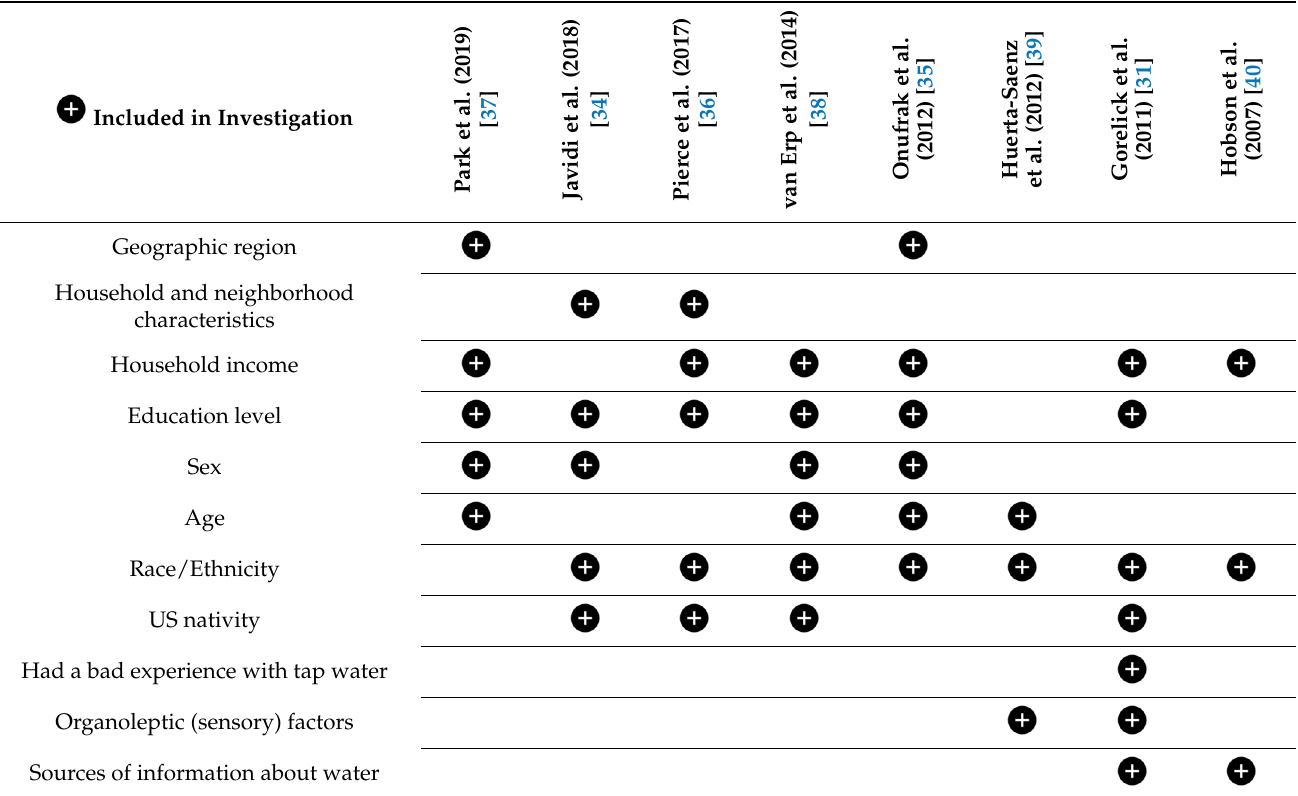
Organoleptic (sensory) factors